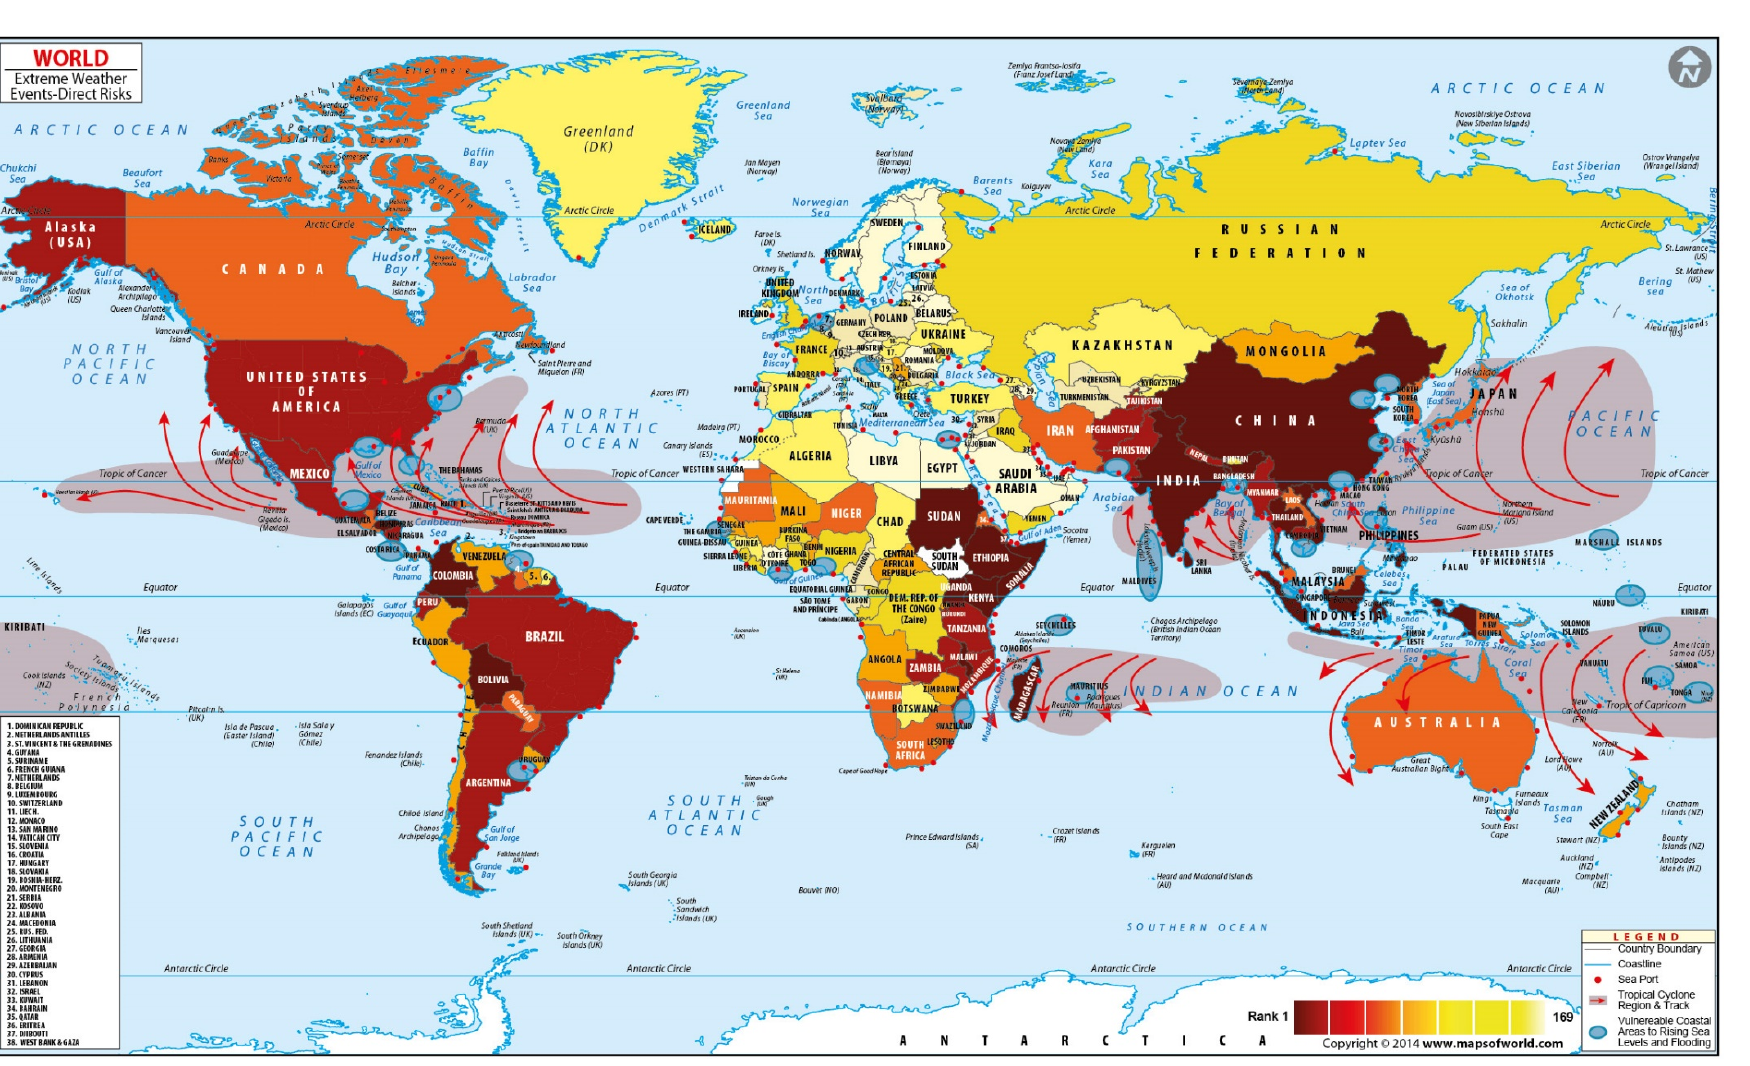
Figure A3. Map of sea level rising conditions globally and extreme weather (Courtesy: Mapsofworld) .